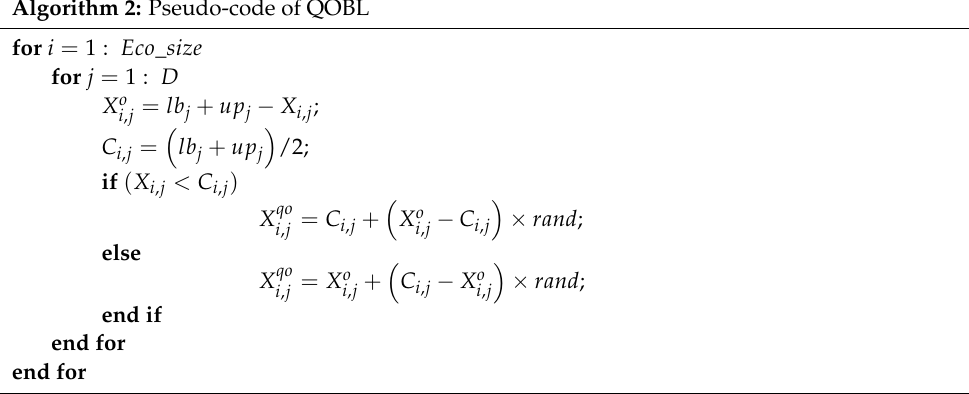
Algorithm 2 defines the QOBL pseudo-code to the novel population. Algorithm 2: Pseudo-code of